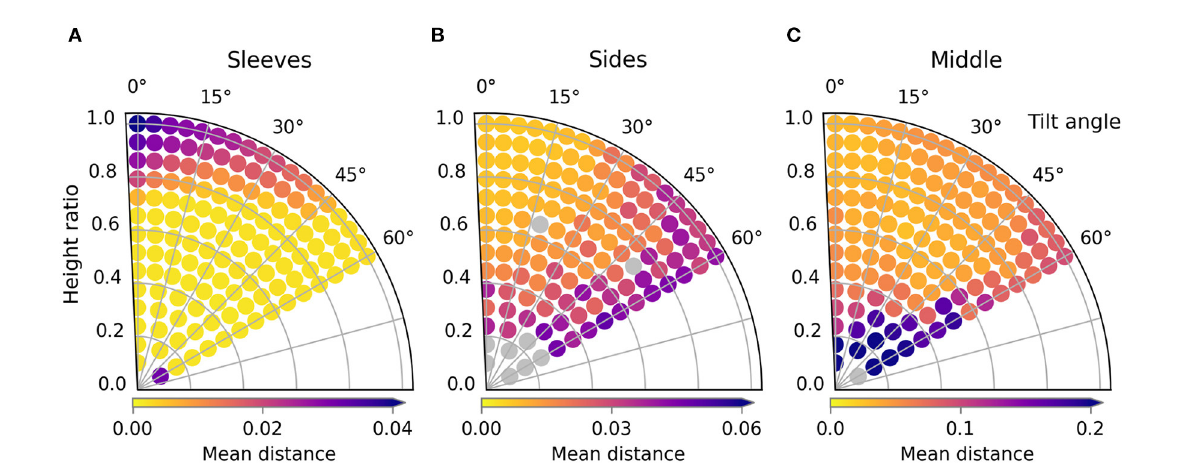
FIGURE13 Trajectory performances for the three phases of the folding sequence: the folding of the sleeves (A) , the sides (B) , and then the final fold over the middle (C) . The material used in this sequence is the default cotton. The gray dots in the figures represent simulations for which no loss was calculated because they crashed due to forced self-intersection of the